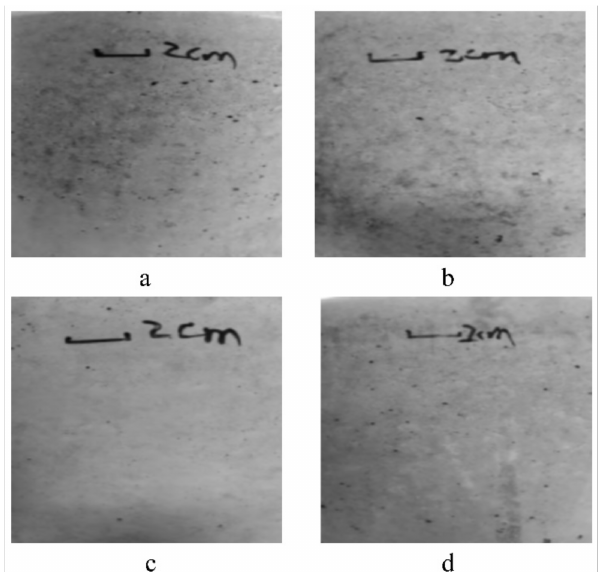
Figure 21. Concrete appearance under composite mixing of chemical admixture ( a ) without the water reducer and air-entraining agent; ( b ) only with the air-entraining agent; ( c ) with both the water-reducing agent and the air-entraining agent; ( d ) only with the water